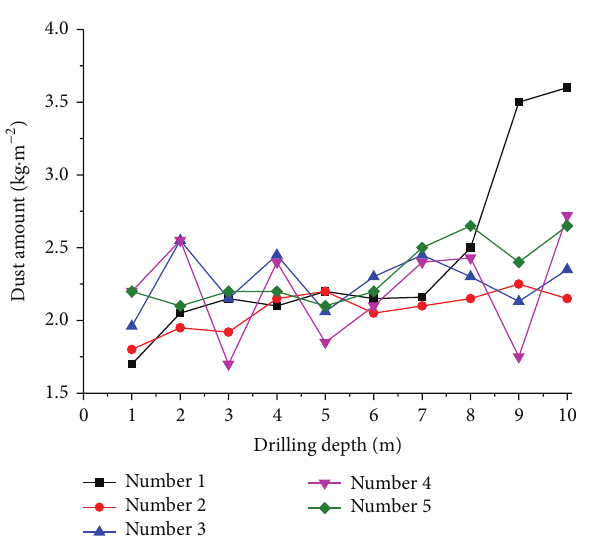
Figure 5: Coal dust amount changing curves.